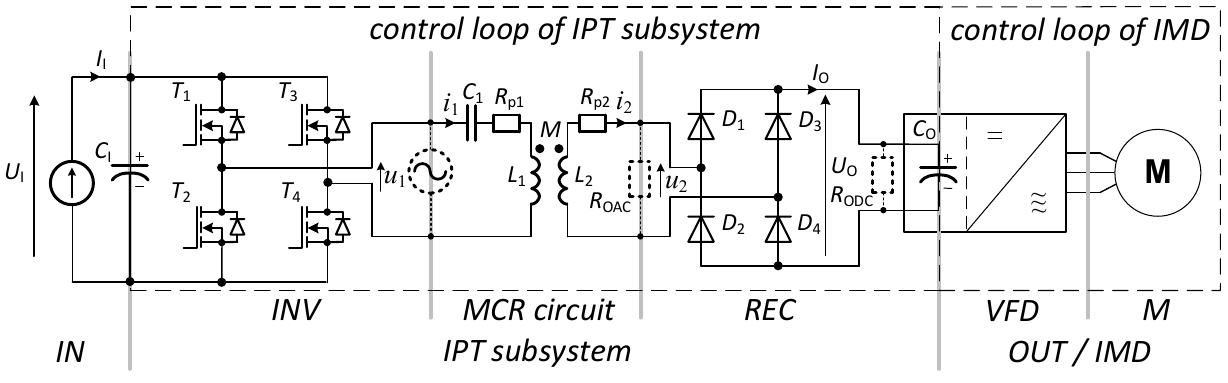
Figure 2. Schematic of the IPT-IMD system.